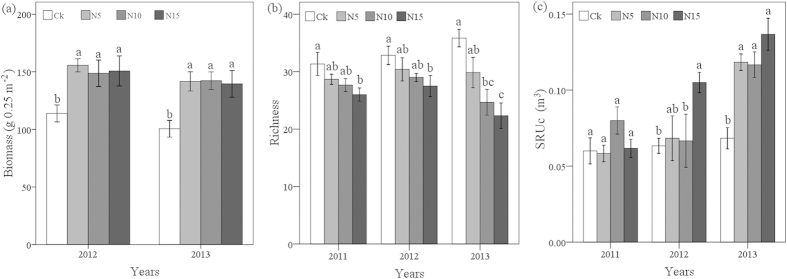
Effects of N addition on (a) biomass, (b) species richness and (c) SRUc (mean ± SE, n = 6). Values with the same letter within a year are not significantly different (p > 0.05).